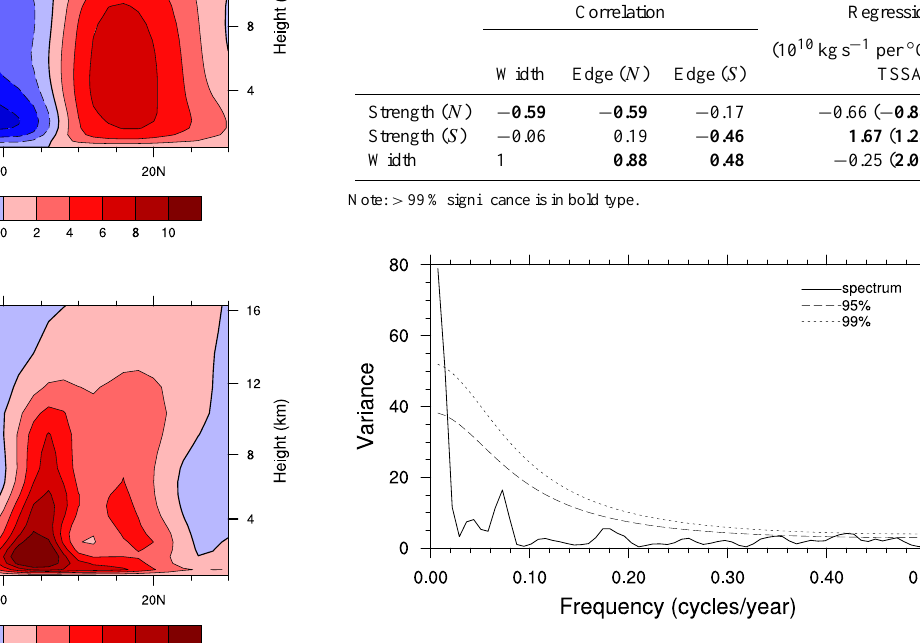
Fig. 5. Spectrum and red-noise confidence intervals for the time series of the annual mean width of the Hadley